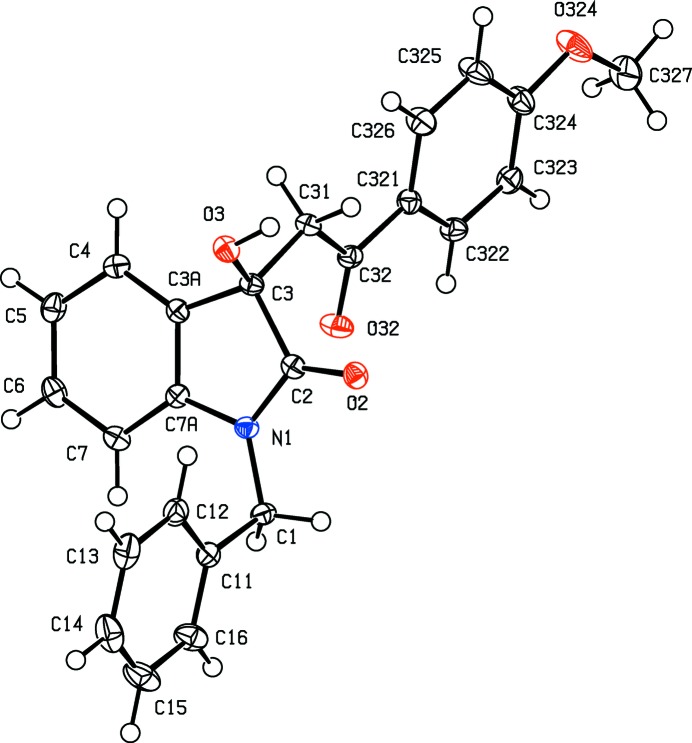
The mol­ecular structure of the R enanti­omer of com­pound (Ic), showing the atom-labelling scheme. Displacement ellipsoids are drawn at the 30% probability level.